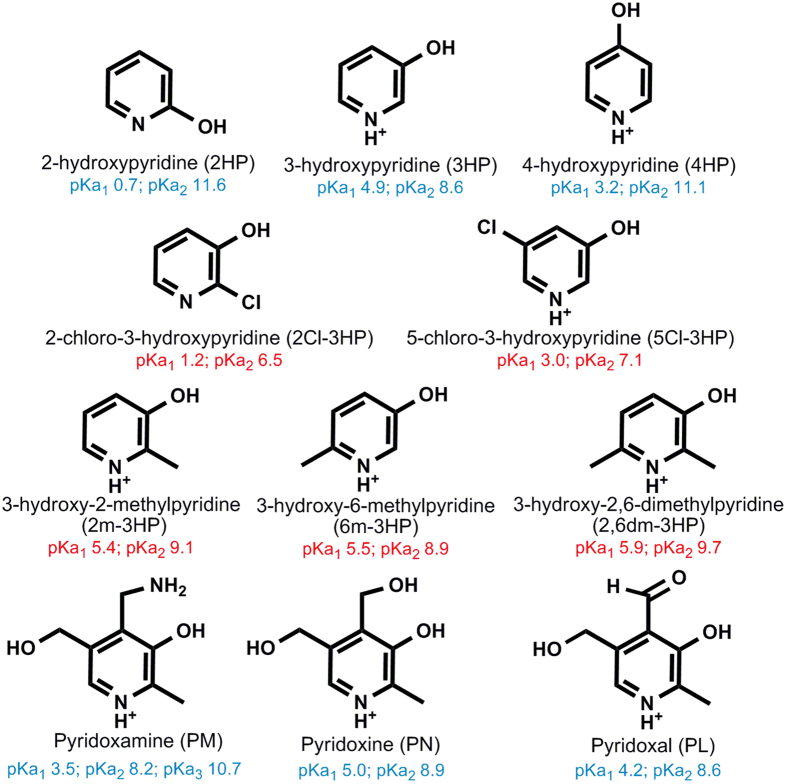
Chemical structures of the main ionic forms at pH 2.0 of the eleven different hydroxypyridines (HPs) used in this work.The protonation states of the pyridine and phenol groups were derived from the corresponding pKa values, which were either obtained from bibliography5960 (blue) or determined spectrophotometrically in this work (red).